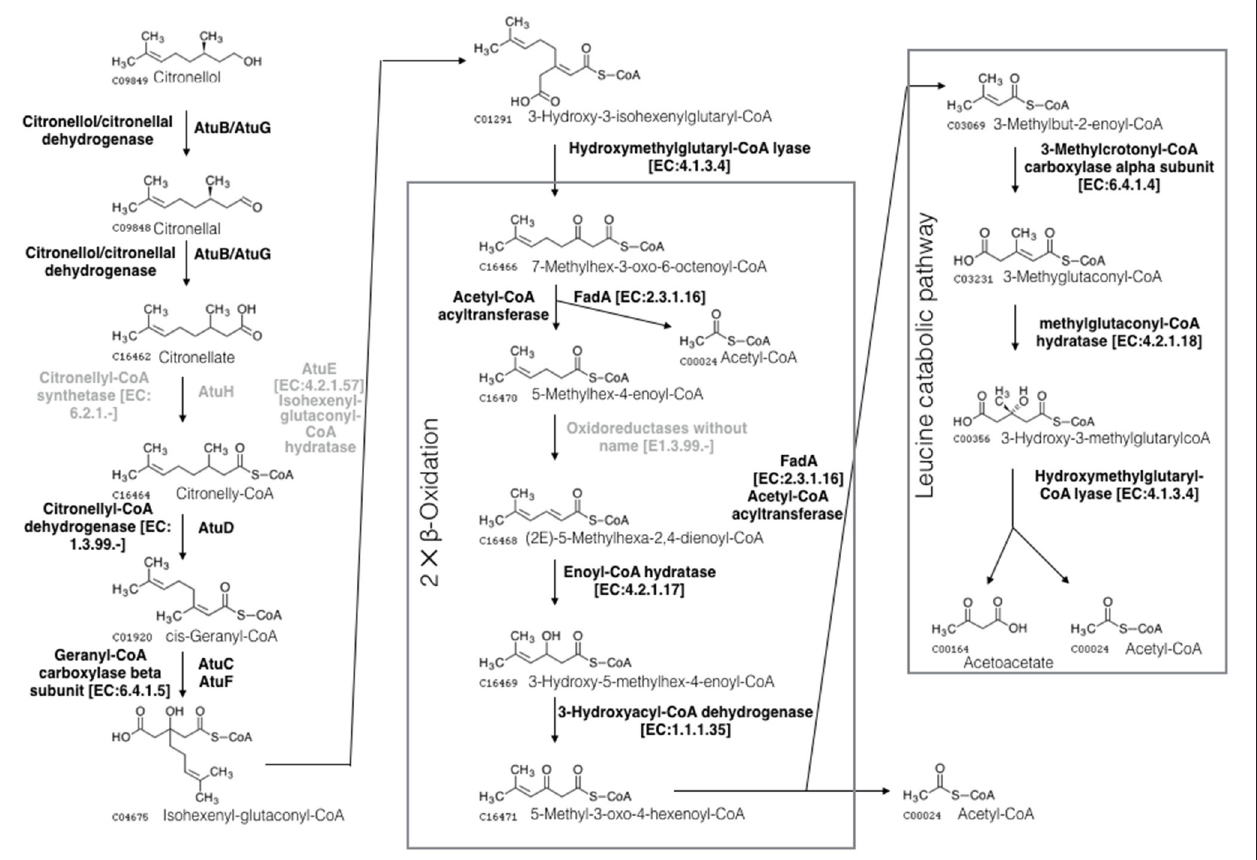
FIGURE 2 | Schematic of the microbial citronellol degradation pathways according to Förster-Fromme et al. (2006). Citronellol is oxidized to its corresponding acid (citronellate) by the citronellol/citronellal dehydrogenase AtuB or AtuG. Citronellate is subjected to carboxylation, hydration and the removal of acetyl-CoA, producing 7-methyloctanoyl-3-oxo-6-octenol-CoA. This component is subjected to two rounds of β -oxidation that lead to the production of 3-methylbut-2-enoyl-CoA. This metabolite then flows into the leucine catabolic pathway, generating acetyl-CoA and acetoacetate. Three molecules of acetyl-CoA are generated during the pathways, which can be utilized as carbon and energy sources by the microorganism. The enzymes missing in the M12 SAG are shown in gray.